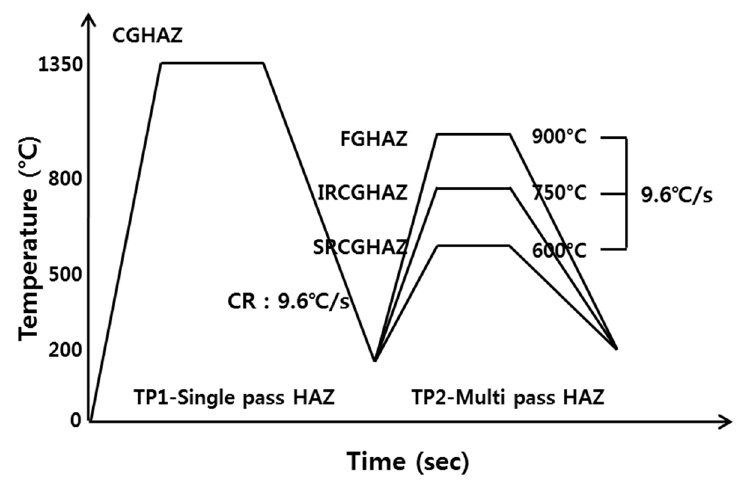
Figure 2. Schematic diagram of the simulated thermal cycles.